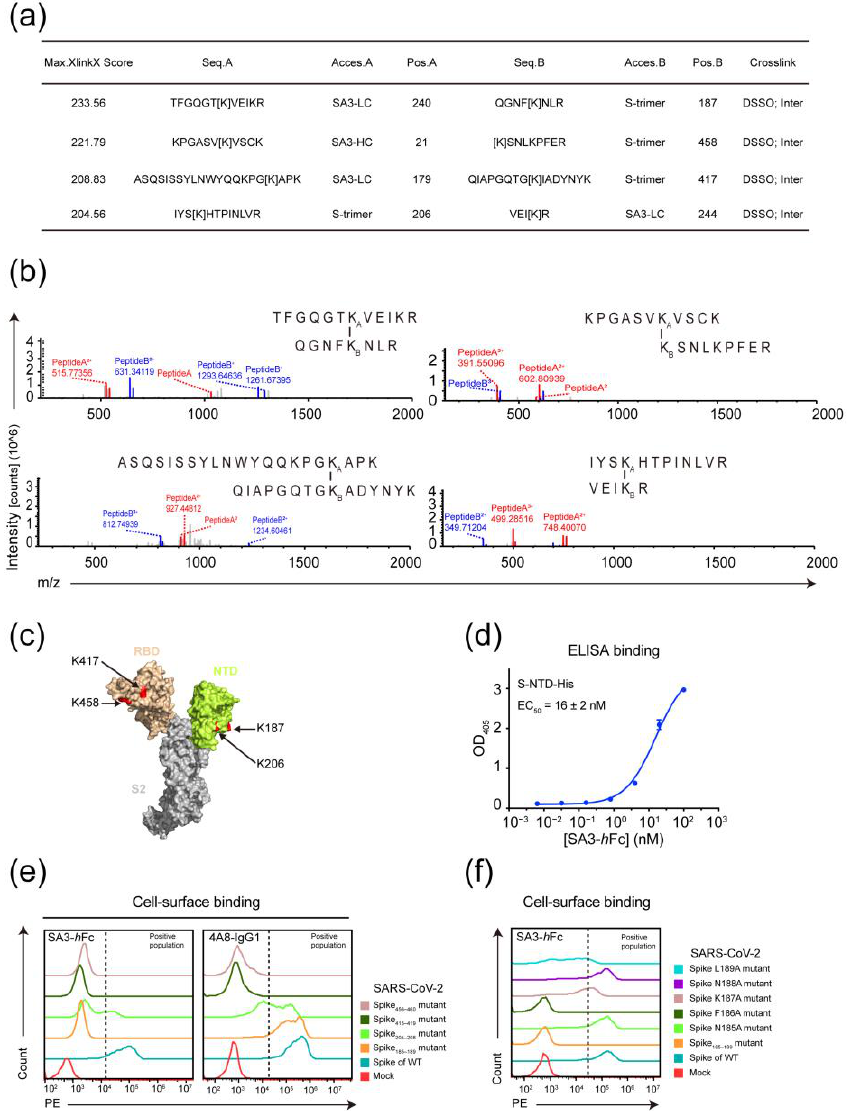
Figure 3. Epitope mapping of SA3 on the spike of SARS-CoV-2. ( a ) Top 4 hit peptides with XlinkX scores in high-resolution MS analyses. ( b ) Secondary MS showing crosslinked peptides. ( c ) Location of SA3 binding sites on the spike of SARS-CoV-2. The monomer structure of the SARS-CoV-2 spike is displayed by PyMOL. The RBD is shown in orange, and the NTD is shown in lemon yellow. The crosslinked lysines mediated by SA3 binding on the spike are shown in red and indicated by arrows. ( d ) Dose-dependent binding of SA3- h Fc to S-NTD-His was monitored in triplicates as OD 405 changed by ELISA assay and fitted to obtain the apparent EC 50 value. ( e ) FACS-based cassette mutagenesis of 5 residues on Spike 185 – 189 , Spike 204 – 208 , Spike 415 – 419 , and Spike 456 – 460 of SARS-CoV-2 using alanine- scan. ( f ) FACS-based point mutagenesis on Spike 185 – 189 of SARS-CoV-2 using alanine-scan. Colored traces represent the association of SA3- h Fc or 4A8-IgG1 with different mutant or WT spikes of SARS- CoV-2 on HEK293T cells membrane in ( e , f ). Positive binding populations were as indicated. 3.4. Mutually Non-Exclusive Binding and Synergistic Neutralization of SA3 and S-E6 against SARS-CoV-2 The mutually non-exclusive binding of SA3- h Fc vs. ACE2- m Fc to the S protein (Fig- ure 2d) observed above suggests SA3 is most likely orthogonal to an RBD-binding anti- body with the S protein. S-E6 was previously identified as an RBD-targeting NAb through competitive blockage of the ACE2 attachment and binding of viral spikes [19]. The neu- tralization activities of the NTD-targeting antibody SA3- h Fc against wild-type (WT) and variant SARS-CoV-2 spikes were evaluated in a PSV infection assay and compared to S-